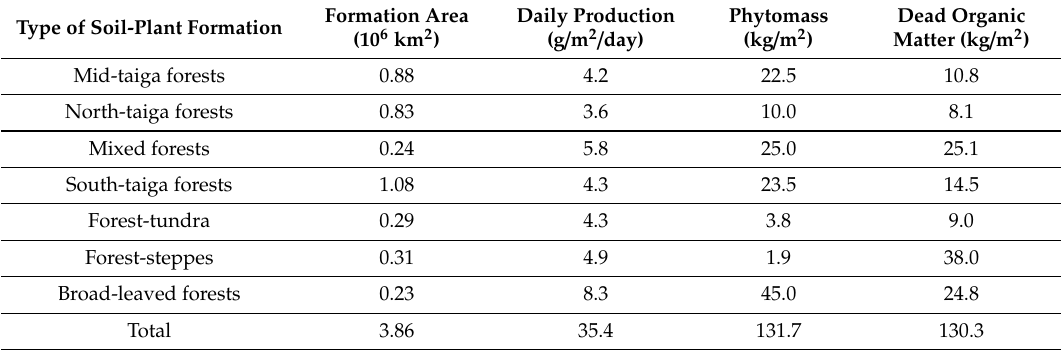
Table 5. Quantitative characteristics of soil-plant formations (SPFs) covering Siberian areas where fire is